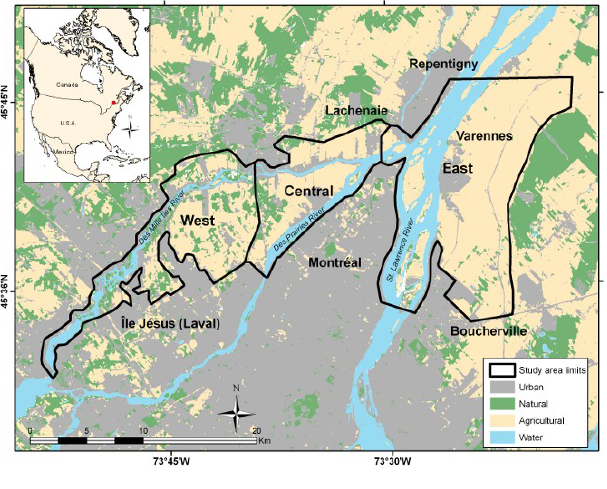
Fig. 1 . Location of the west, central, and east zones where Canada Geese ( Branta canadensis maxima ) were surveyed and tracked in 2004 near Montréal,